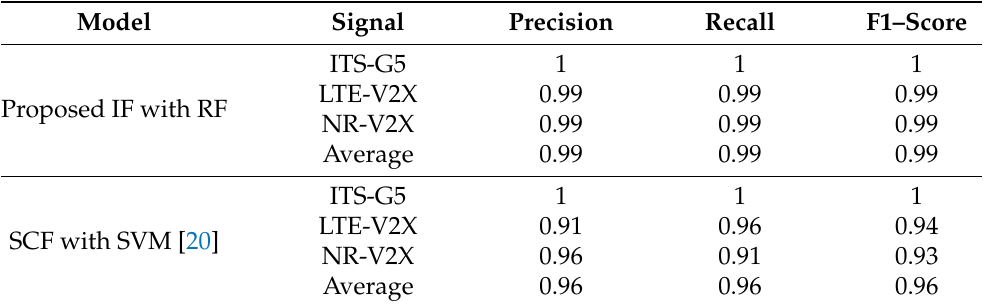
Table 2. Performance metrics of random forest and support vector machine